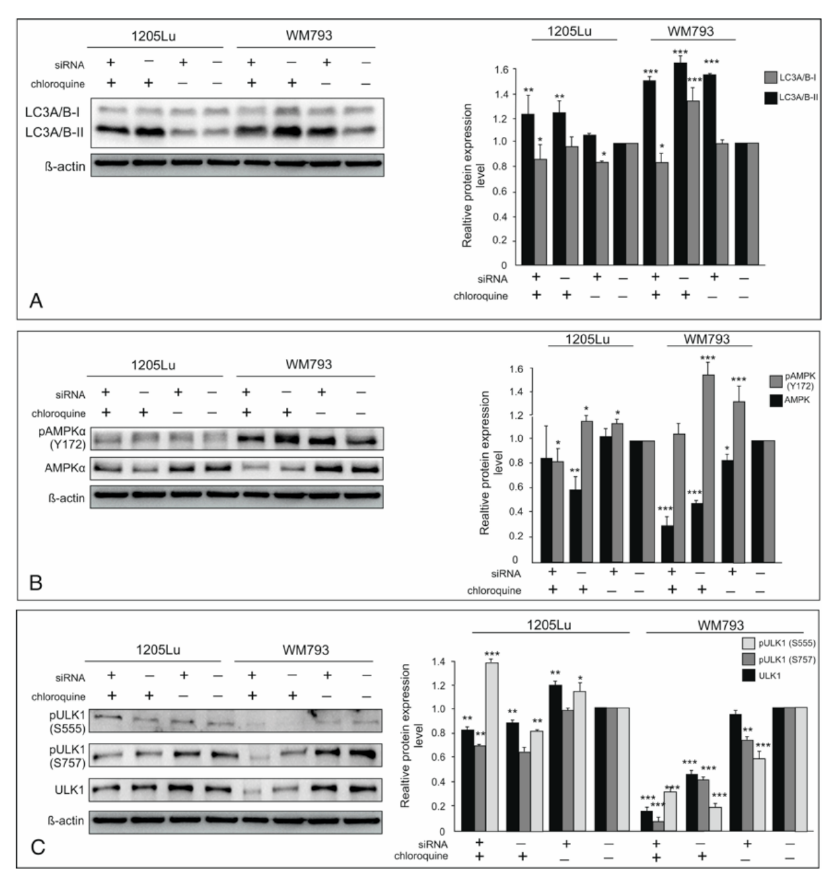
Figure 2. Effect of ILK knockdown on autophagy induction. “+” refers to siRNA ILK or chloroquine; “ − ” refers to silencer negative control cells. The expression of ( A )—LC3-II, both phosphorylated and total ( B )—AMPK, ( C )—ULK1 were determined by Western blotting. Representative blots are displayed. The histograms are a quantitative representation of data after densitometry (mean ± SD) of three independent experiments. β -actin was used as a protein loading control. Asterisks indicate significant differences from control cells. Values are denoted as * p < 0.05, ** p < 0.01, and *** p <